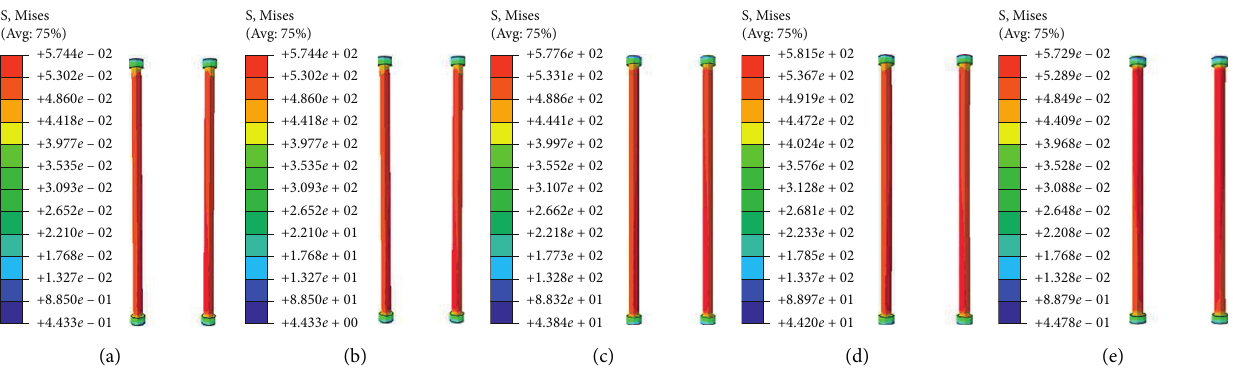
Figure 18: Stress nephogram of high-strength bolts: (a) PCB-SLCC-1; (b) PCB-SLCC-2; (c) PCB-SLCC-3; (d) PCB-SLCC-4; (e) PCB-